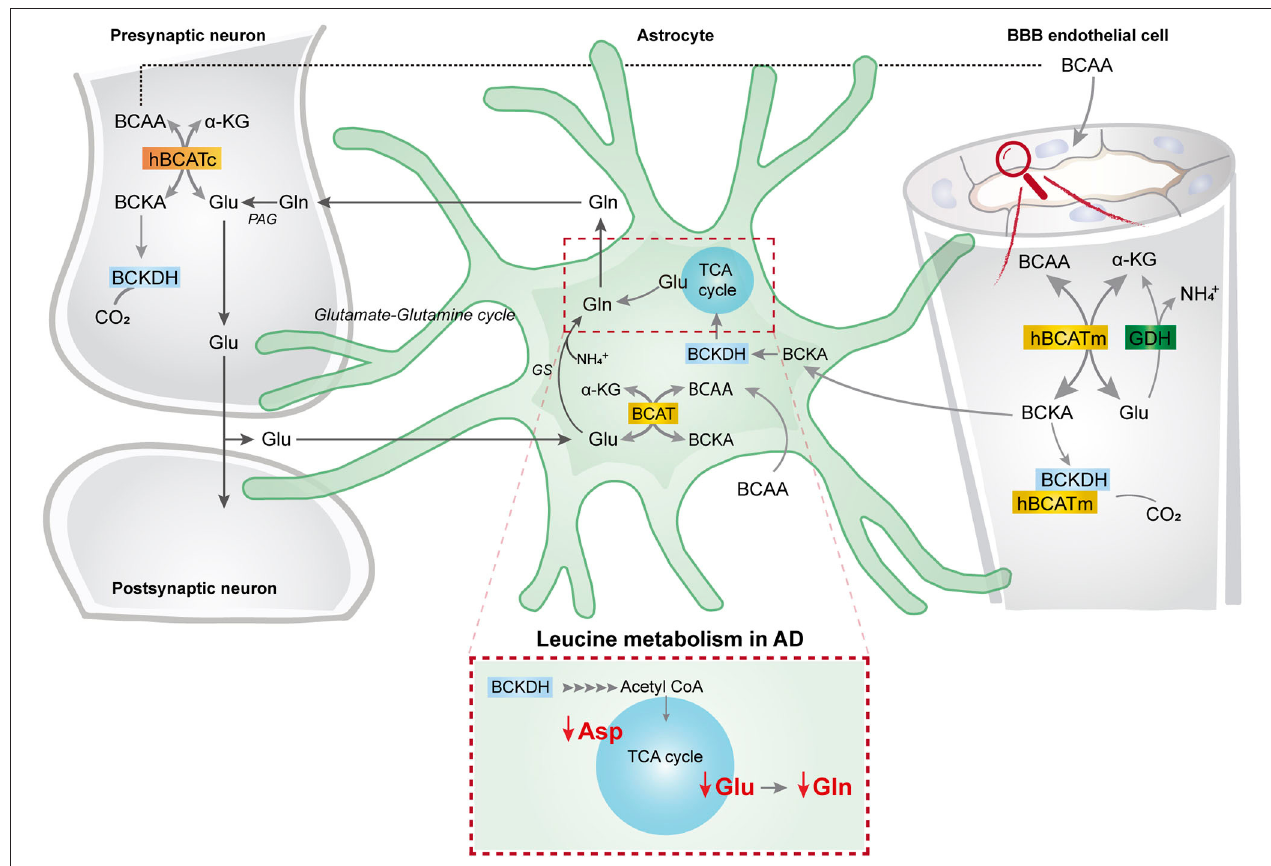
FIGURE 8 | BCAA oxidative metabolism and nitrogen transfer in human astrocytes and potential blood brain barrier-astrocyte-neuron axis. BCAAs are taken up by the blood brain barrier (BBB) endothelial cells, and then BCAAs can undergo transamination by the action of BCATm, forming glutamate and the branched-chain α -keto acids (BCKAs), KIC, KIV, and KVM. In the reverse reaction when α -ketoglutarate is formed from glutamate, the BCAT/GDH metabolon in the endothelial cells may release ammonia, and BCAAs can be released and taken up by neurons or astrocytes. Alternatively, BCKAs from endothelial cells can be released or metabolized by the BCKDH/BCATm metabolon. Likewise, in neurons, BCAAs can also be transaminated, producing BCKAs and glutamate. BCKAs can be further metabolized by BCKDH, and glutamate can be used for neurotransmission. Glutamate from neurons in the synaptic cleft can be taken up by astrocytes. Astrocytes synthesize glutamine from glutamate and ammonia which is catalyzed by glutamine synthetase (GS) and is released for neuronal uptake to replenish the glutamate pool, in the so-called glutamate-glutamine cycle. The data indicate that in astrocytes, BCAAs may be transaminated by the action of BCAT, and that the BCAA carbon skeleton can be oxidized by BCKDH activity. This set of metabolic reactions give rise to acetyl CoA or succinyl CoA, replenishing TCA cycle intermediates and amino acids in the astrocytes. Furthermore, we present evidence of reduced aspartate, glutamate, and glutamine total and labeling amounts after incubation with [U- 13 C]leucine in AD astrocytes (represented within the dotted box). This altered leucine metabolism in AD astrocytes may contribute to the disrupted neurotransmitter homeostasis observed in the AD brain. BBB, blood brain barrier; BCATm, mitochondrial branched-chain aminotransferase; Glu, glutamate; α -KG, α -ketoglutarate, GDH, glutamate dehydrogenase, NH + 4 , ammonium; BCKA, branched-chain α -keto acids; KIC, α -ketoisocaproate; KIV, α -ketoisovaleric; KMV, α -keto- β -methylvalerate; BCAT, branched-chain aminotransferase; BCKDH, branched-chain α -keto acid dehydrogenase; Gln, glutamine; GS, glutamine synthetase; BCATc, cytosolic branched-chain aminotransferase; PAG, phosphate-activated